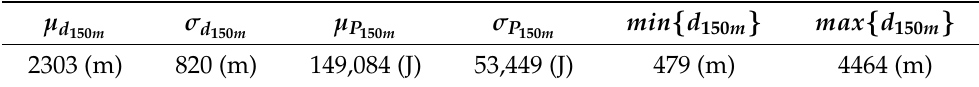
Table 6. Mean µ and standard deviation σ of 150 m flight corridor solutions.